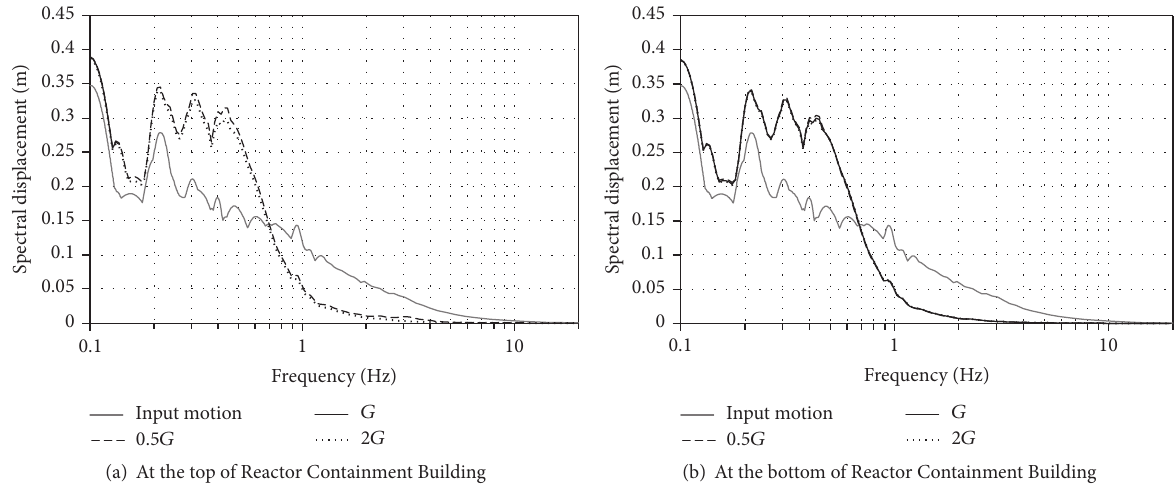
Figure 14: Comparison of response spectra displacement under horizontal excitation for different soil shear modulus.